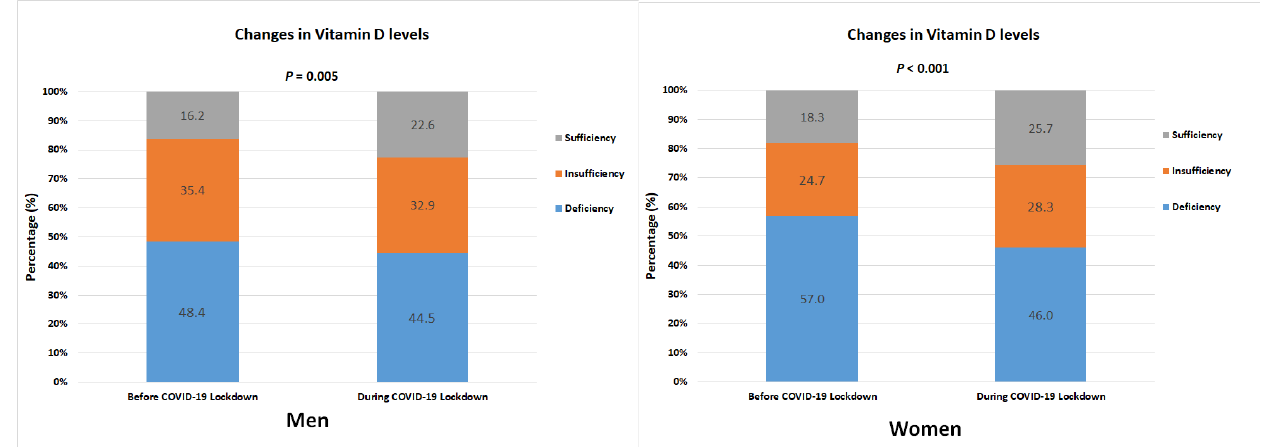
Table 4. The rates of 25(OH)D deficiency, insufficiency, and sufficiency before and during COVID- 19 lockdown periods.